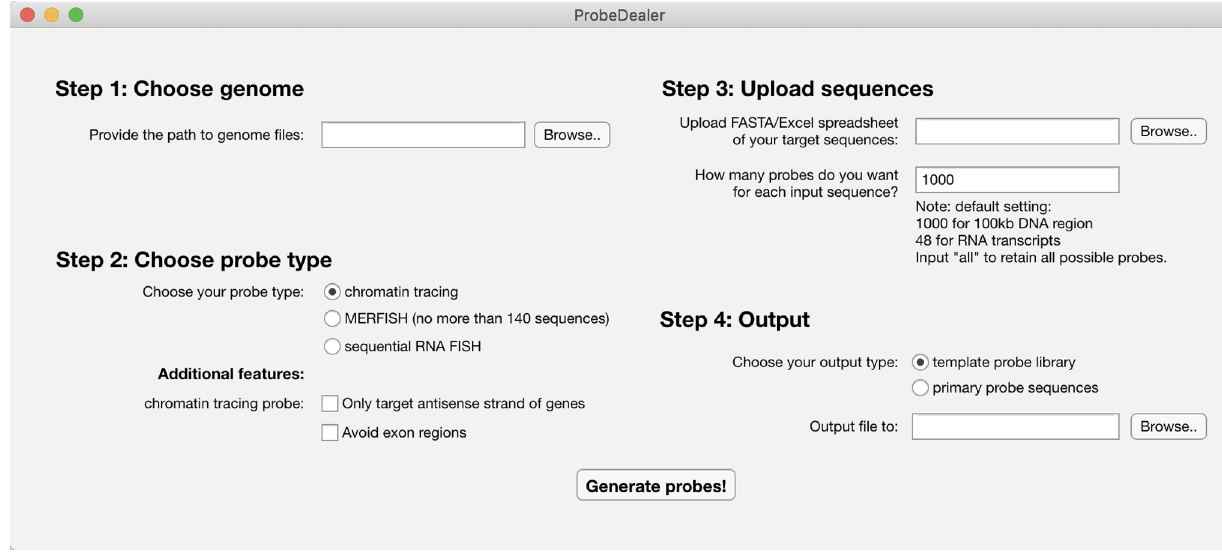
Figure 2. ProbeDealer user panel. ProbeDealer allows users to provide genome files and input target sequences. Users can specify their desired probe type, probe features, output type and path, and numbers of probes for each input